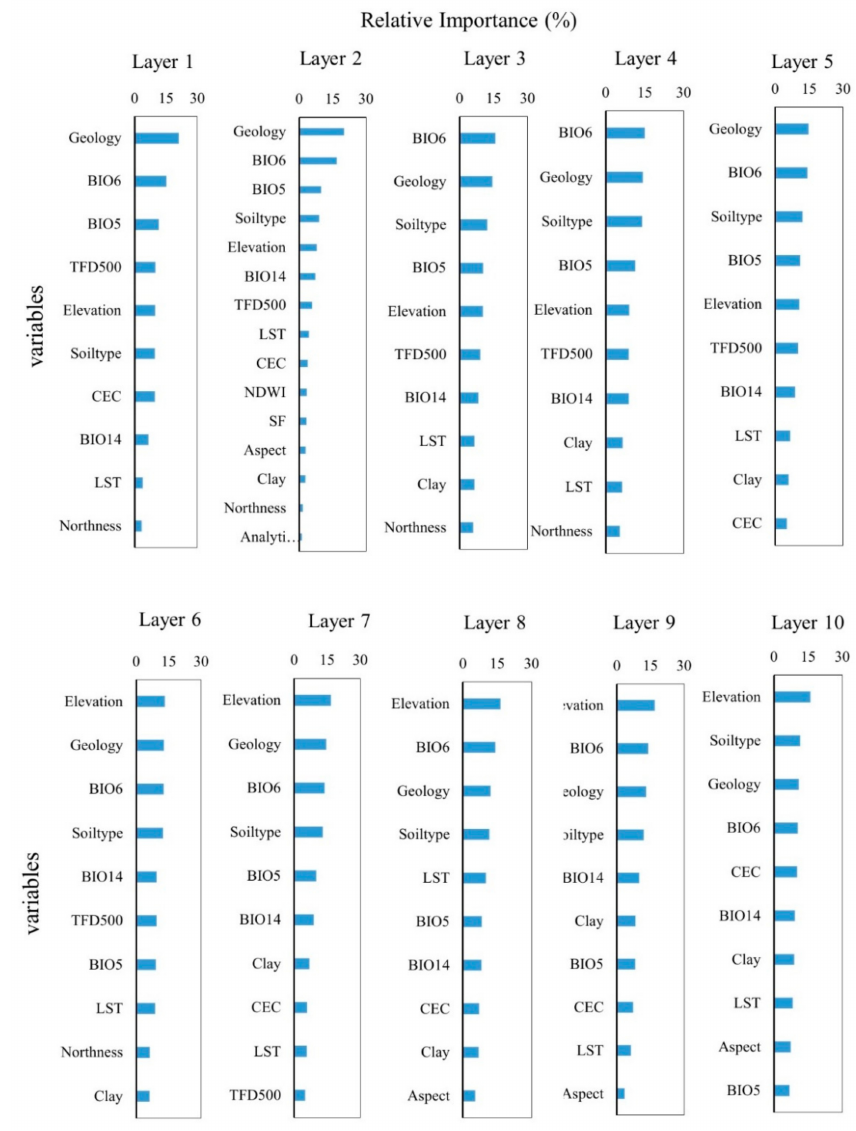
Figure 8. Variable importance for SOC stocks prediction in different depth at Ag > 50–Pas < 50 class by